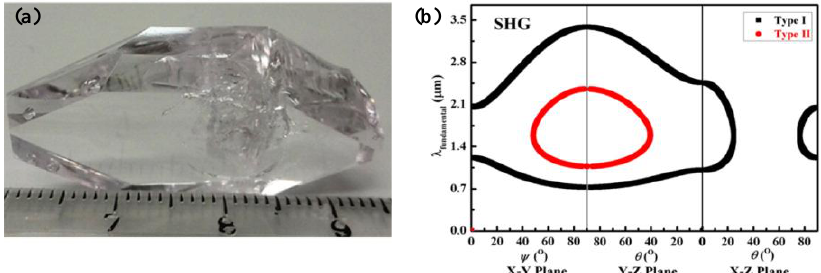
Figure 18. ( a ) The as-grown Ba 3 (ZnB 5 O 10 )PO 4 crystal with [101]-oriented seed; ( b ) Phase-matching calculation for Ba 3 (ZnB 5 O 10 )PO 4 crystal: PM angle curves for type-I (black) and type-II (red) SHG as a function of the fundamental wavelength. Reprinted (adapted) with permission from Ref. [153], Copyright (2016) American Chemical Society.